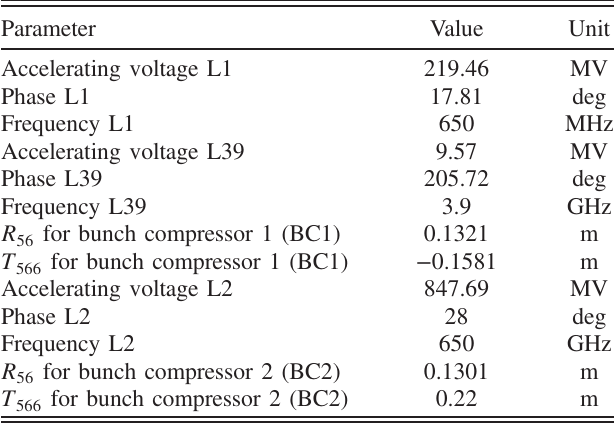
TABLE II. Optimized parameters from the one-dimensional